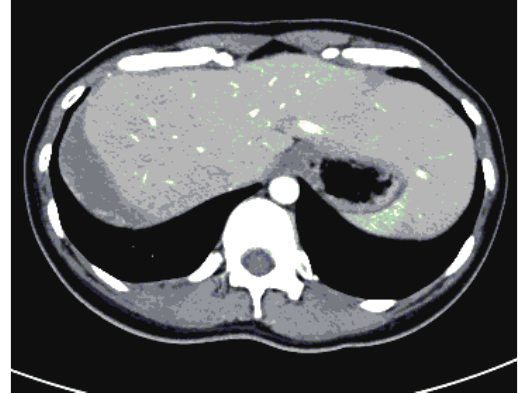
Figure 2 Enhanced computed tomography transverse image demonstrating a mixed hyperdense dense mass of 70 × 21 × 59 mm and visible vessel within